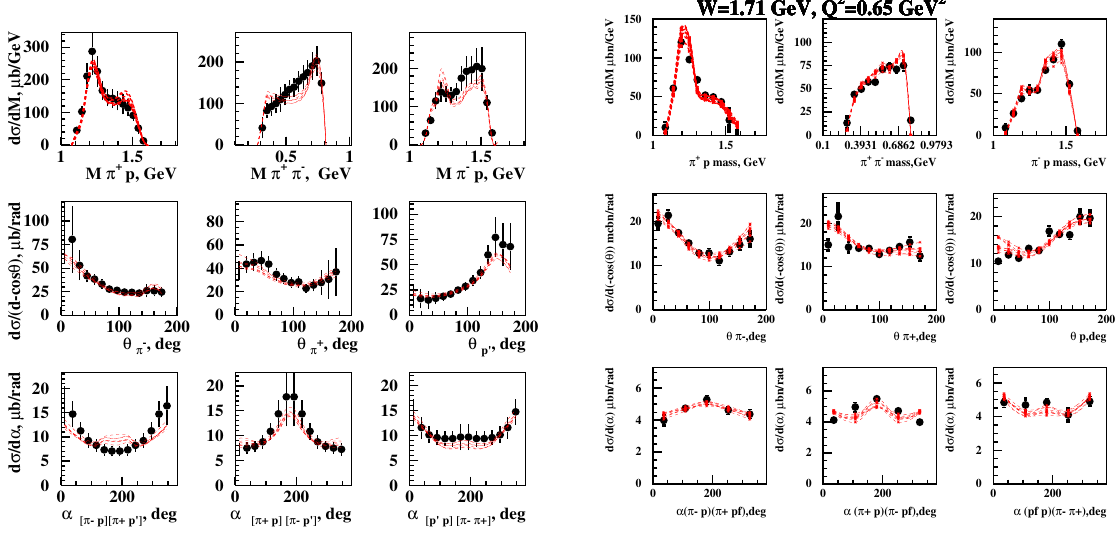
Figure 5. (Color online) Description (red curves) of the CLAS π + π − p photoproduction data (black filled circles with error bars) at W = 1.74 GeV and Q 2 = 0. GeV 2 [17] (left) and electroproduction data at W = 1.74 GeV and Q 2 = 0.65 GeV 2 [23] (right) achieved in the fit within the JM model after implementation of the candidate N (cid:48) (1720)3 / 2 +